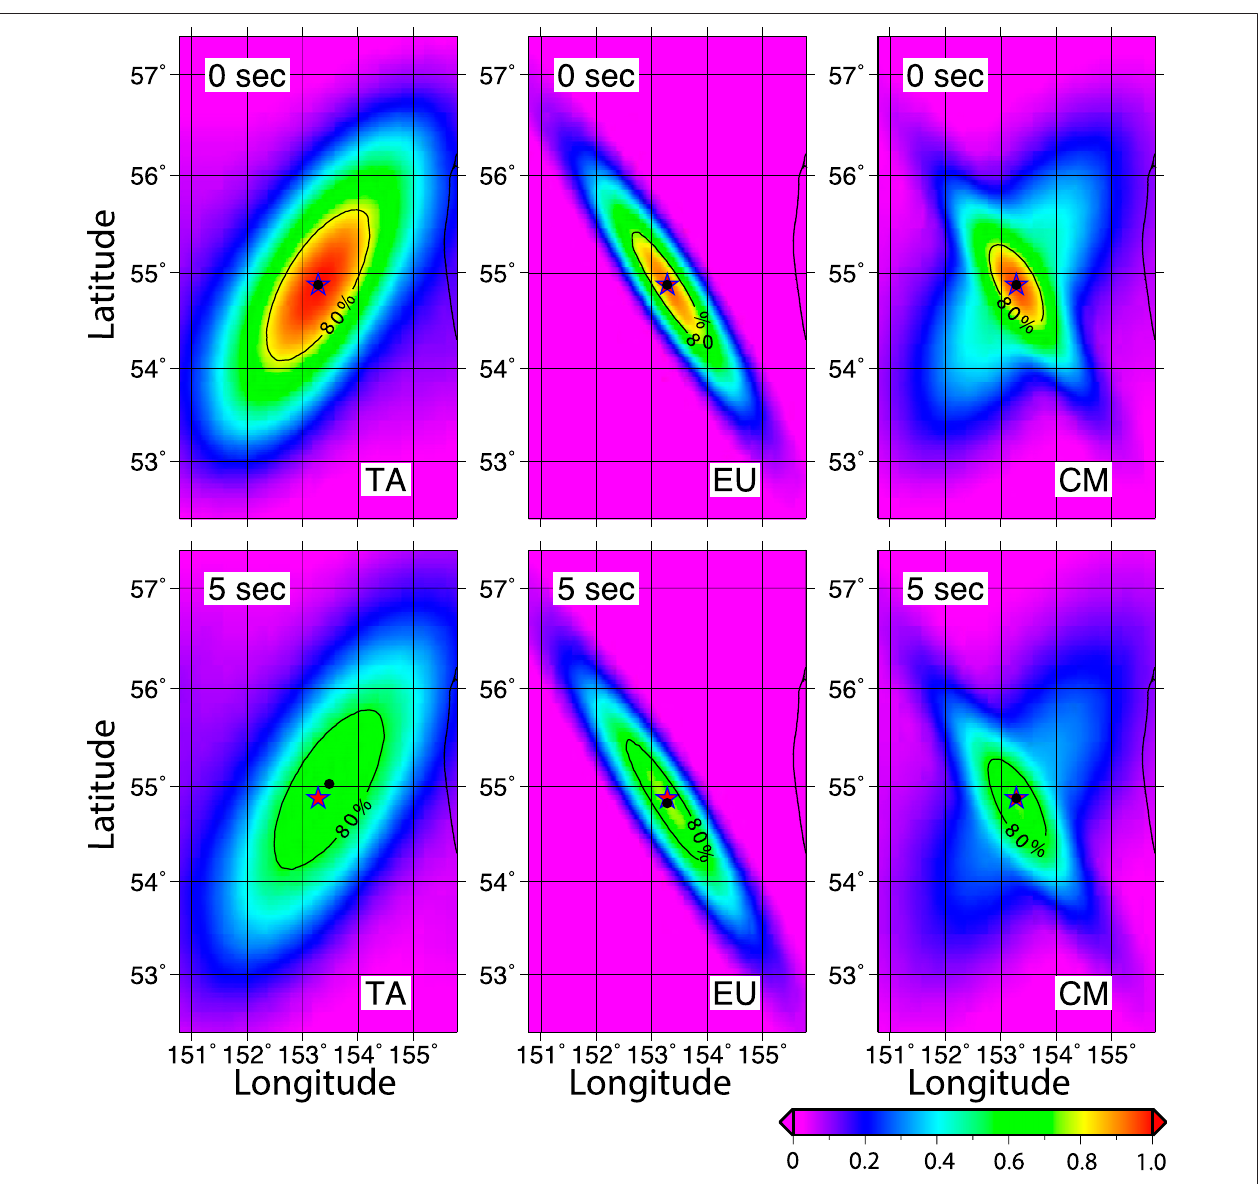
FIGURE 7 | Rupture imaging of the two seismic sources by back-projecting synthesized P -waves from the TA (left panels) and the EU (middle panels) in the low- frequency band and the combined imaging (right panels). The color bar denotes the normalized power of potential subevents. Red stars indicate the epicenters. The contour shows the 80% of the maximum normalized